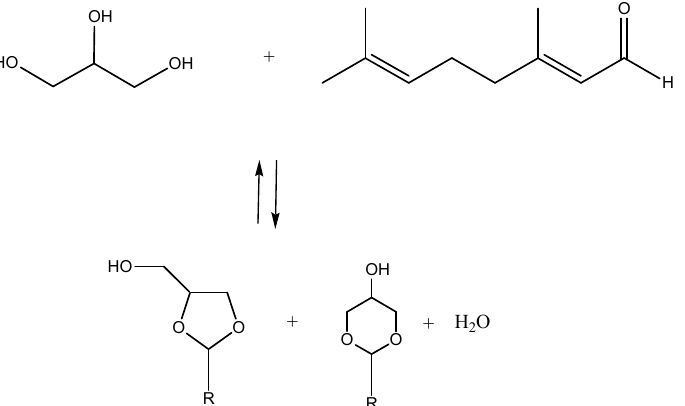
Figure 6. Reaction scheme of acetalization of glycerol with citral, where R = —CH=C(CH 3 )CH 2 CH 2 CH=C(CH 3 )(CH 3 ).